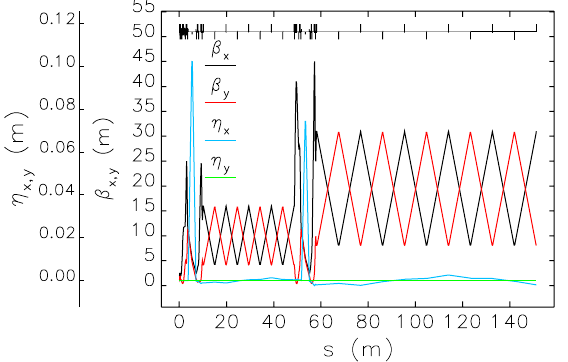
FIG. 4. Beta functions and dispersion functions of the overall accelerator, from Linac0 (in Fig. 1) end with an electron beam energy of 54 MeV to linac end with a beam energy of 6 GeV. Black curve: horizontal beta function; red curve: vertical beta function; blue curve: horizontal dispersion function; green curve: horizontal angular dispersion function. Periodic FODO cells are employed for the X -band rf cavity based linac, with an average beta function of 10 and 20 meters in Linac2 and Linac3, respectively. Simple matching sections are also employed